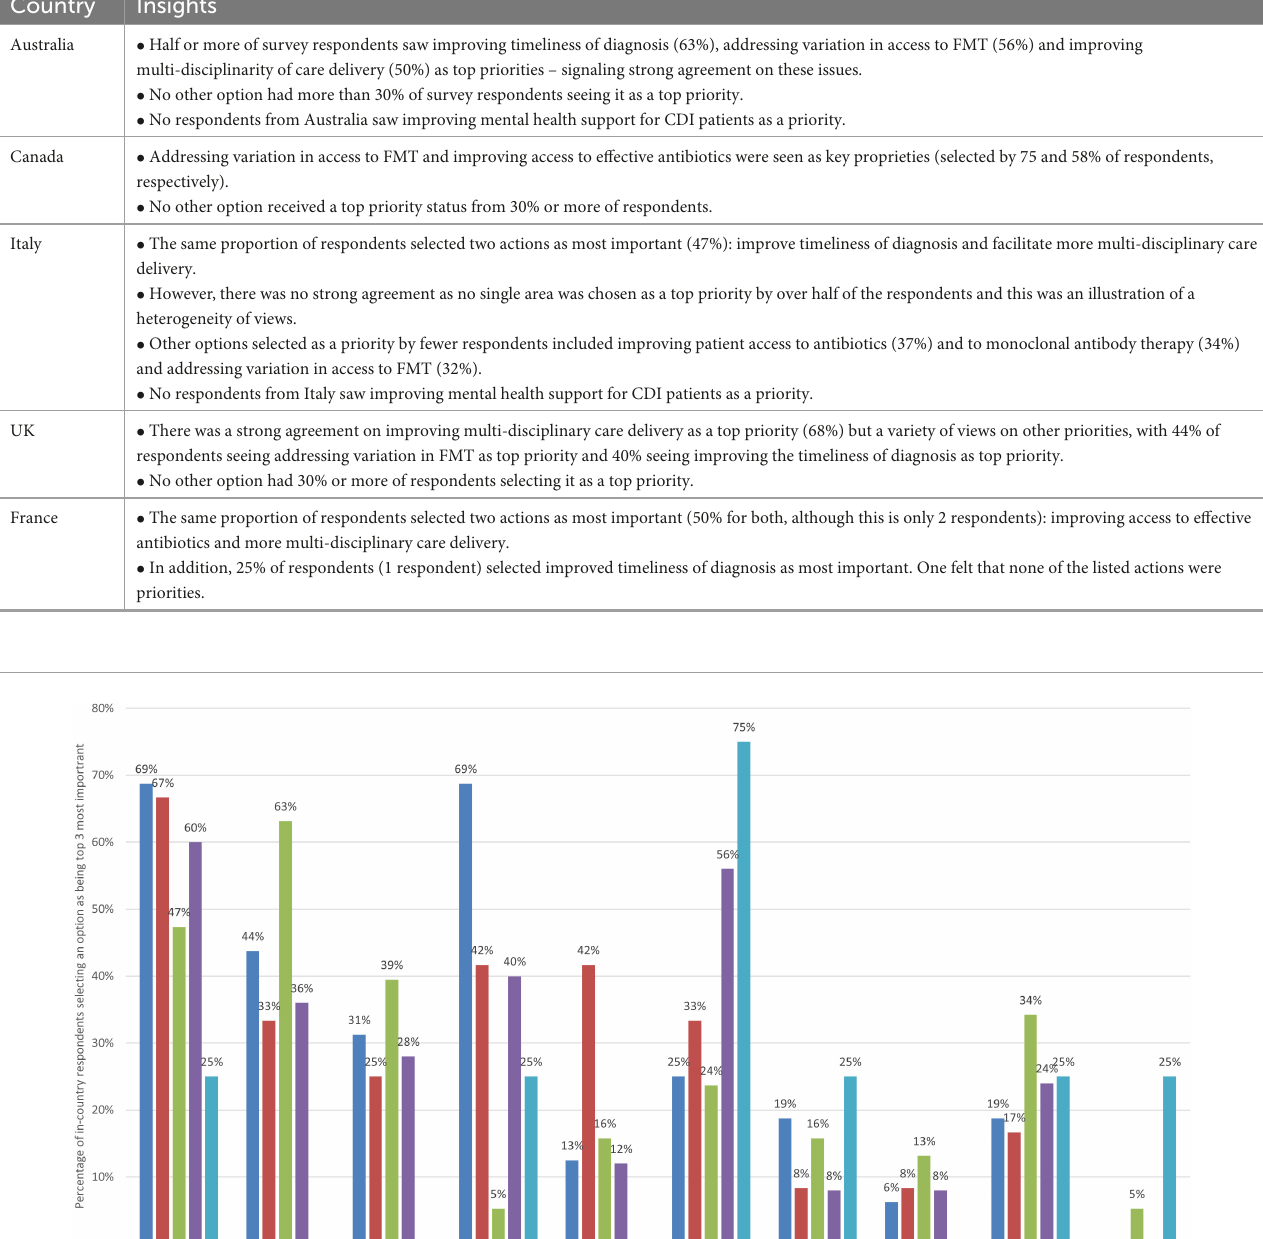
improvement actions they thought were the most